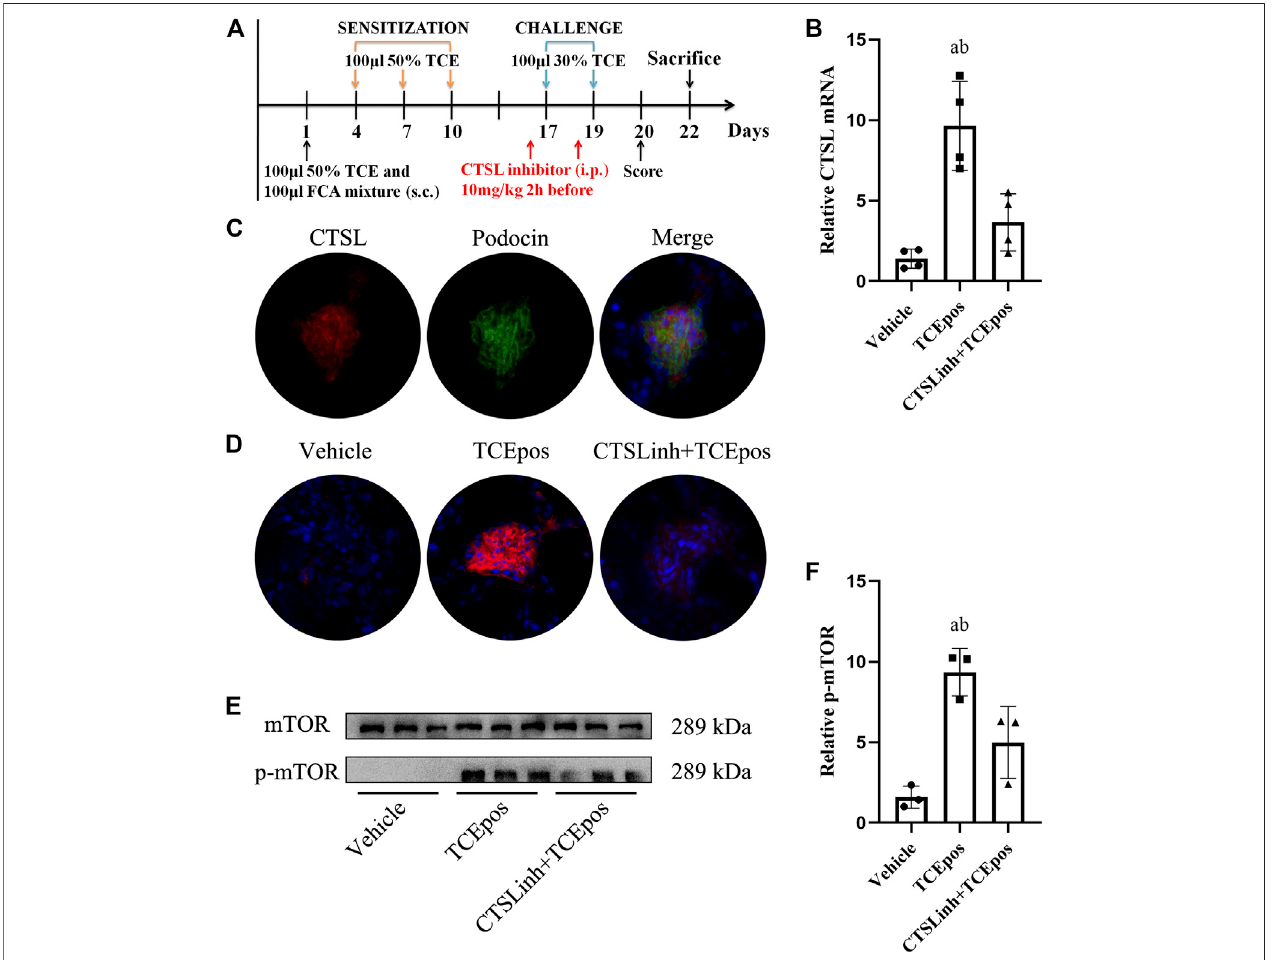
FIGURE 8 | Cathepsin L (CTSL) mediated hyperactive mTORC1 signaling in TCE-induced glomerular injury. (A) CTSL inhibitor (CTSLinh) was applied to mice by intraperitoneal injection at 10 mg/kg 2 h before each challenge. (B) The relative expression of CTSL mRNA in vehicle group, TCEpos group, and CTSLinh + TCEpos groupaccordingtoRT-PCRanalysis( n (cid:1) 4pergroup). (C) Theco-locationofCTSLandpodocin(apodocytemarker)inglomerulusofTCEposgroup. (D) Theexpression of CTSL con fi rmed by immuno fl uorescence test ( n (cid:1) 5 per group). (E) Western blot bands of mTORC1 and p-mTORC1 in vehicle control group, TCEpos group, and CTSLinh +TCEposgroup ( n (cid:1) 3per group). (F) The relative expression ofp-mTOR calculated by gray values inImageJ software. Data arepresented asmean ± SD and determined by one-way ANOVA, * p <